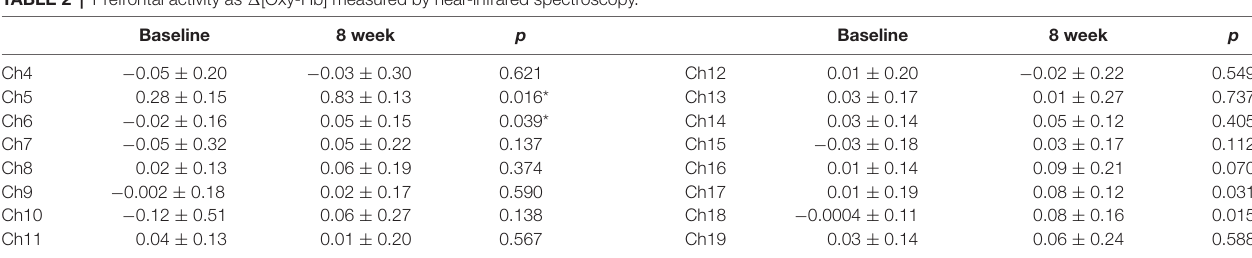
TABLE 2 | Prefrontal activity as ∆ [Oxy-Hb] measured by near-infrared spectroscopy.